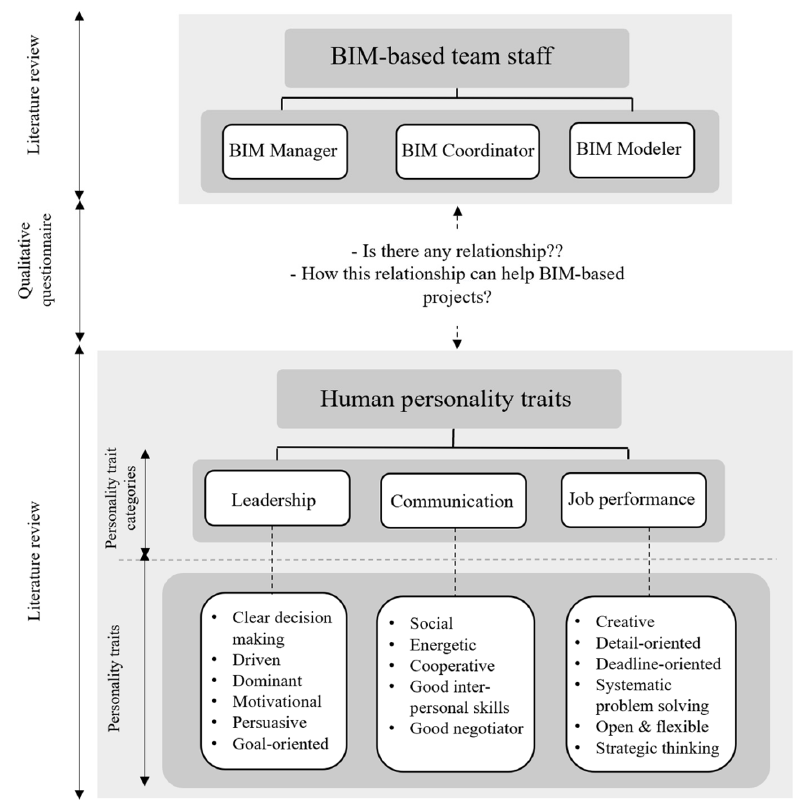
Figure 1. Research